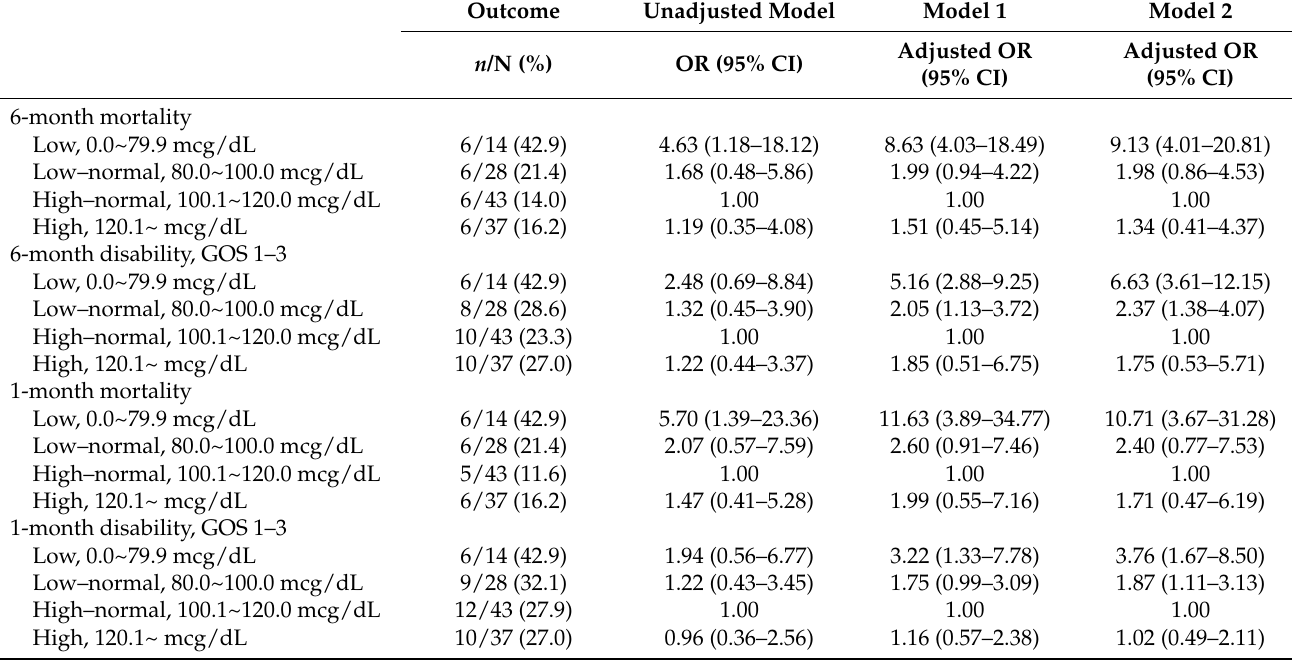
Table 4. Subgroup analysis for TBI patients diagnosed with diabetes mellitus ( n =